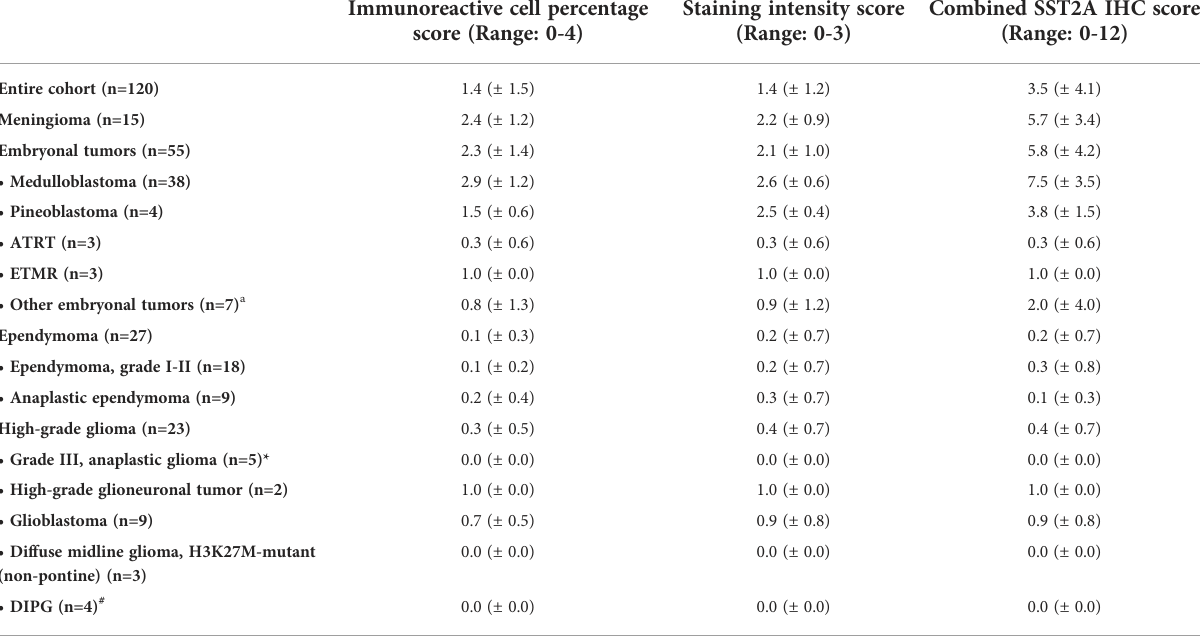
TABLE 2 Summary of SST2A IHC immunoreactive cell percentage, staining intensity, and combined scores based on histopathologic diagnosis. Immunoreactive cell percentage Staining intensity score score (Range: 0-4) (Range: